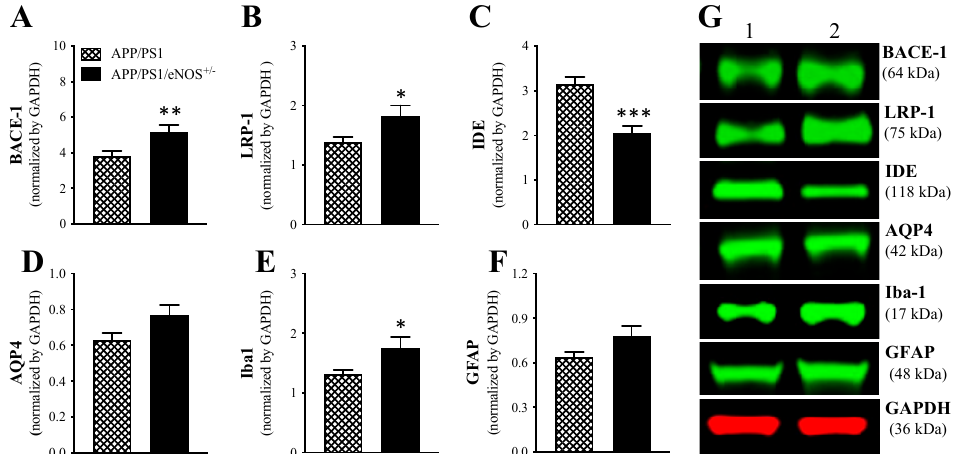
Figure 7. Mean (± SEM) protein expression of beta-site amyloid precursor protein cleaving enzyme 1 (BACE-1; A ), low density lipoprotein receptor-related protein 1 (LRP-1; B ), insulin-degrading enzyme (IDE, C ), aquaporin-4 (AQP4, D ), ionized calcium binding adaptor molecule 1 (Iba-1, E ) and glial fibrillary acidic protein (GFAP, F ) in the anterior cortex of 8-months old male APP/PS1 and APP/PS1/eNOS +/ − mice ( n = 8–12/genotype). ( G ) representative western blots of BACE-1, LRP-1, IDE, AQP4, Iba-1 and GFAP, as well as housekeeping protein glyceraldehyde 3-phosphate dehydrogenase (GAPDH), in APP/PS1 (1) and APP/PS1/eNOS +/ − (2) mice. * indicates a significant difference between groups at * p < 0.05, ** p < 0.01 or *** p < 0.001.